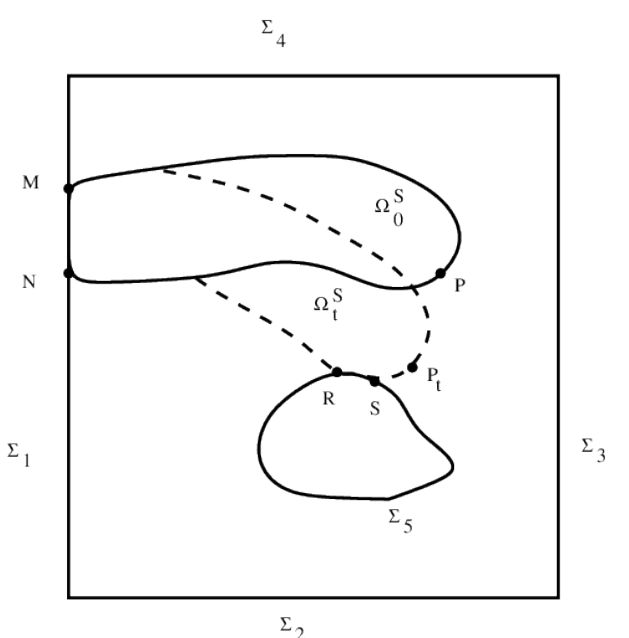
Figure 1. The undeformed structure domain (continuous line) and deformed structure domain (pointed line) in contact with the